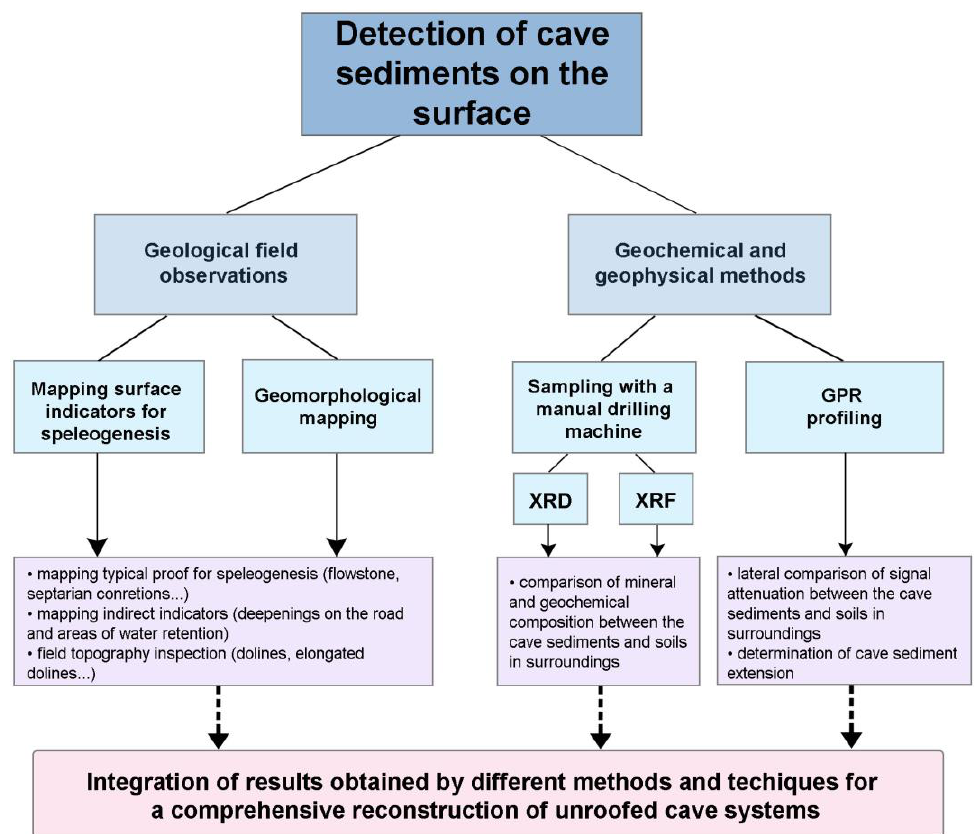
Figure 17. Diagram shows the used methods with the main results, as needed to delineate unroofed cave systems into a whole.